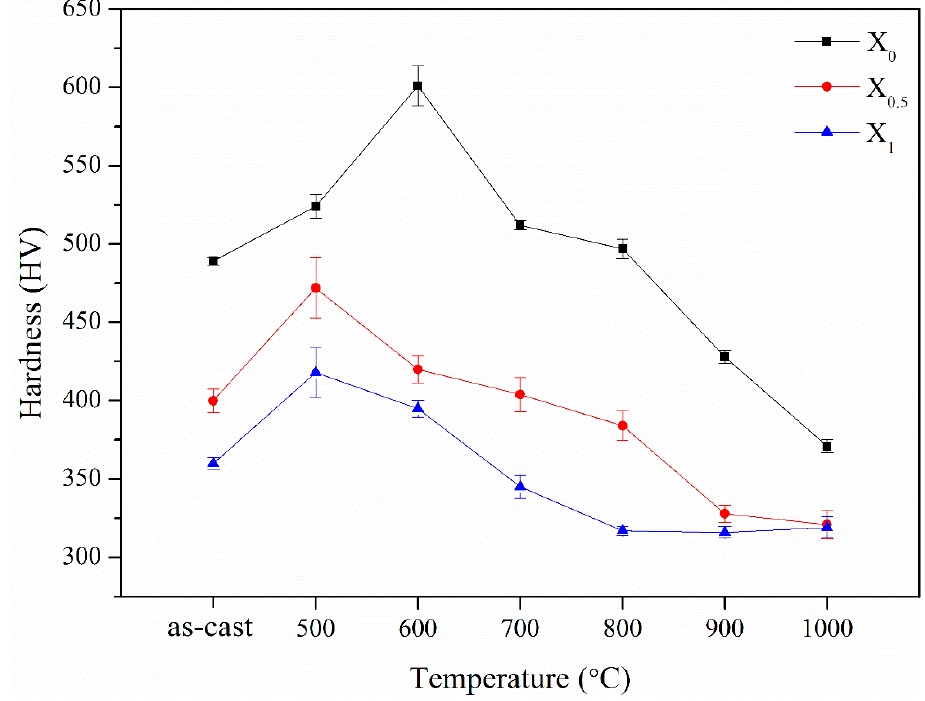
Figure 14. Variations in the hardness of the X 0 , X 0.5 , and X 1 as-cast alloys after aging for 144 h at 500–1000 °C.